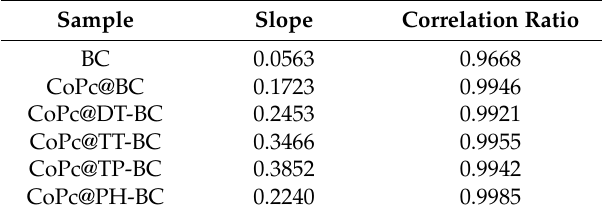
Table 2. Slope and correlation ratios regressed from the adsorbed dye-adsorption time curves. Sample Slope Correlation